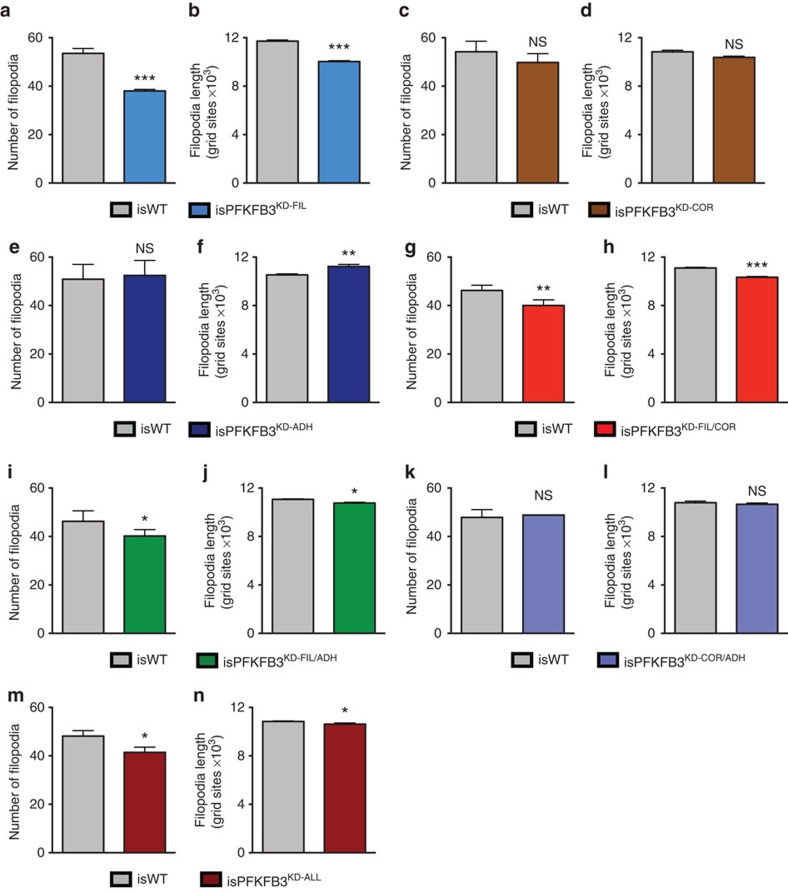
EFIL-containing isPFKFB3KD mechanisms have reduced filopodia.(a-n) Number and length of filopodia for in silico WT (isWT) and in silico PFKFB3KD (isPFKFB3KD) cells, modelled by modifying the single mechanisms EFIL (a,b), ECOR (c,d) and EADH (e,f), and the combinatorial mechanisms EFIL/COR (g,h), EFIL/ADH (i,j), ECOR/ADH (k,l) and EALL (m,n). Data are mean±s.e.m.; n=4–5; NS, not significant, *P<0.05, **P<0.01, ***P<0.001; Student's t-test.